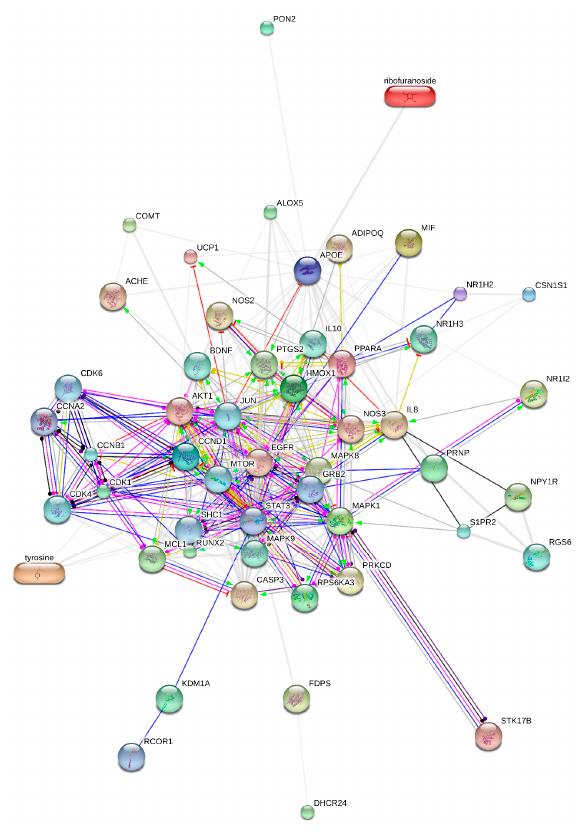
Figure 3. Action view of the protein network of Tiansi Liquid targets. Action type is represented by colored edges, as described here: activation (